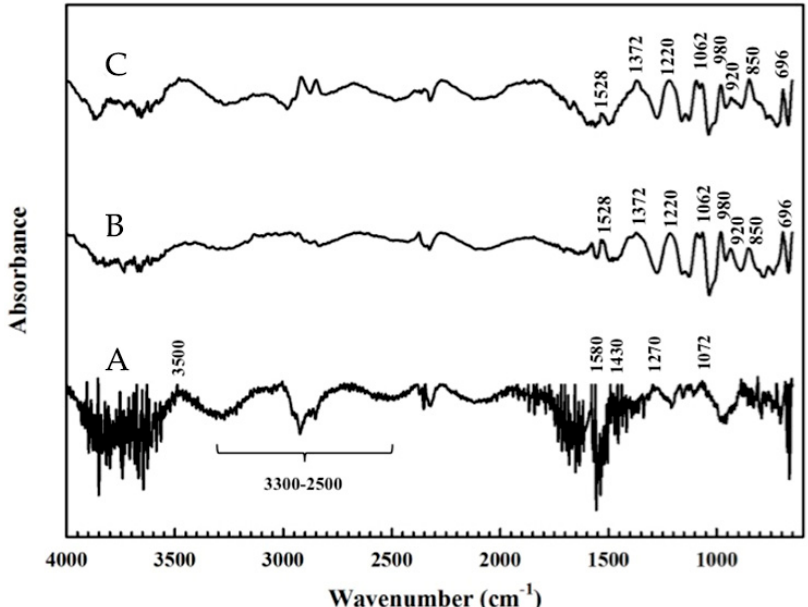
Figure 2. FTIR spectra of ( A ) PL electrode, ( B ) PEDOT film on a PL electrode, and ( C ) PEDOT/PL electrode after HQ measurement.